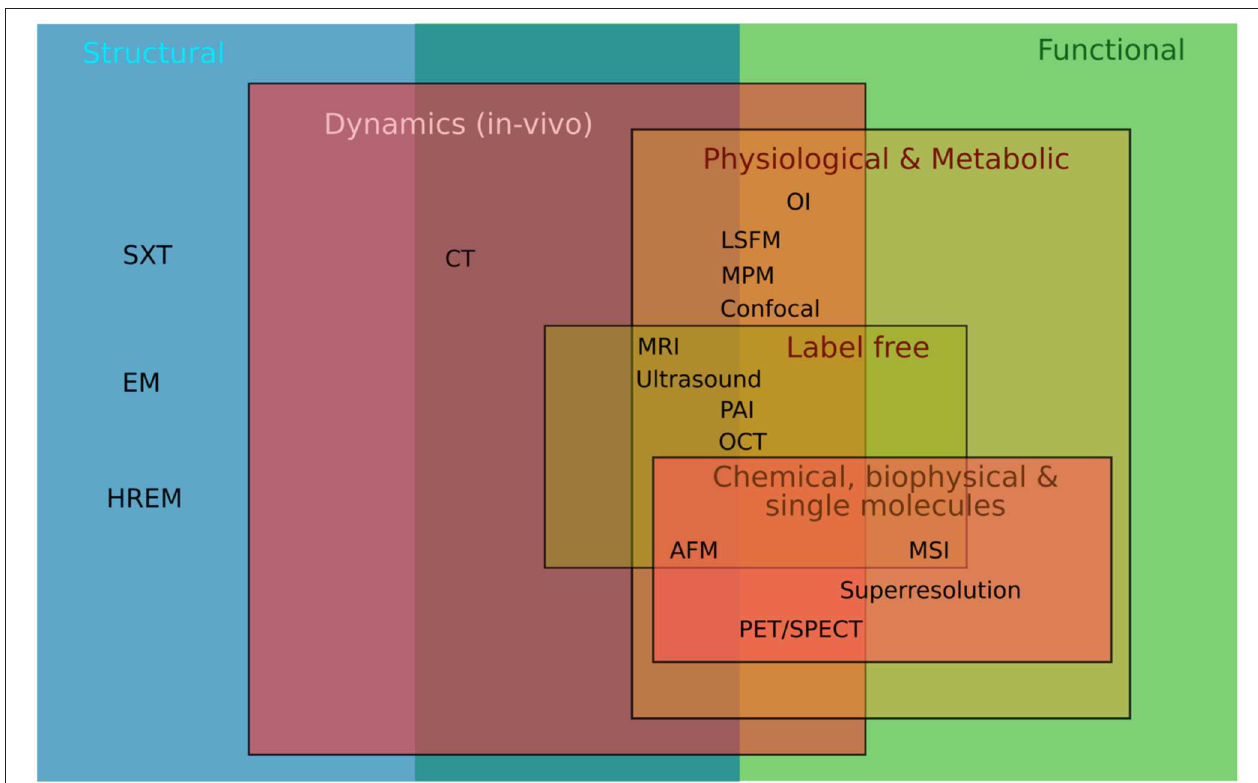
FIGURE 1 | Holistic imaging accessing all relevant information spaces from structural to functional imaging. Representation for the modalities mentioned in the text: SXT, Soft X-ray Tomography; HREM, High Resolution Episcopic Microscopy; EM, Electron Microscopy; CT, Computed Tomography; OI, Optical Imaging including bioluminescence and fluorescence imaging; LSFM, Light Sheet Fluorescence Microscopy; MPM, MultiPhoton Microscopy, Confocal, Confocal Microscopy; MRI, Magnetic Resonance Imaging; Ultrasound, PAI, Photoacoustic Imaging; OCT, Optical Coherence Tomography; AFM, Atomic Force Microscopy; MSI, Mass Spec Imaging; Superresolution, Microscopy such as STORM, PALM, STED; PET/SPECT, Positron Emission Tomography/Single Photon Emission Computed